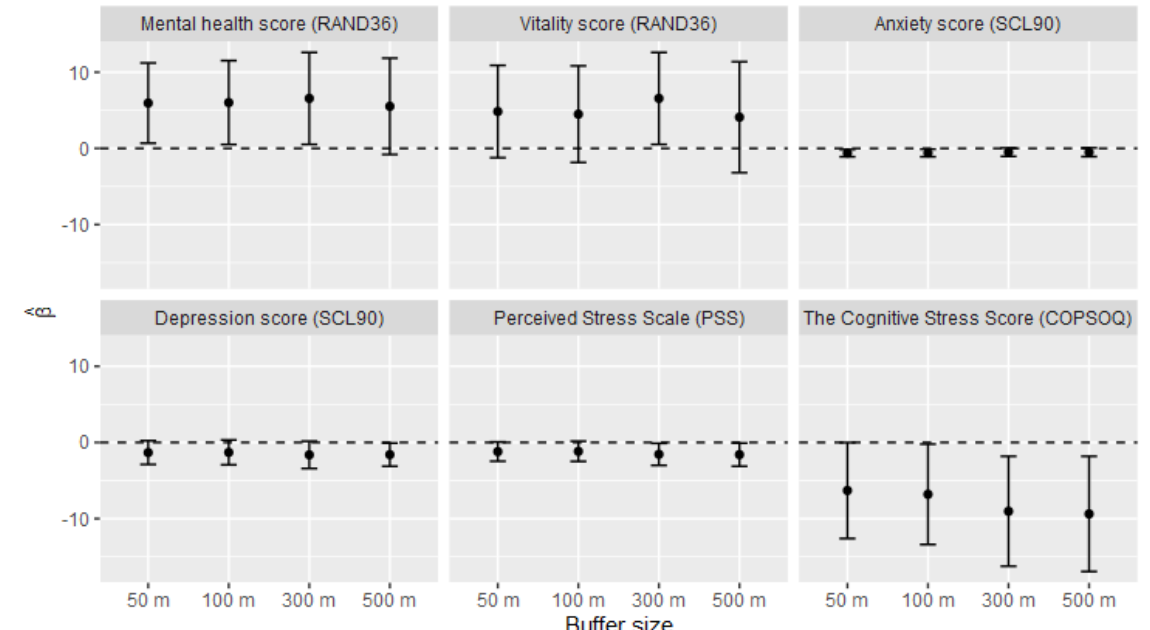
Figure 1. Mental health estimates associated with NDVI within different buffer sizes (models adjusted as in Table 6) (95% CI).